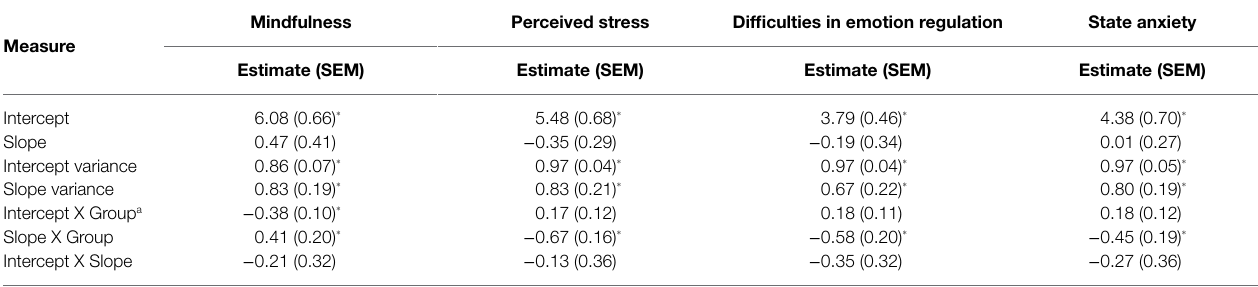
TABLE 4 | Standardized estimates, standard errors, and significance in individual growth curve